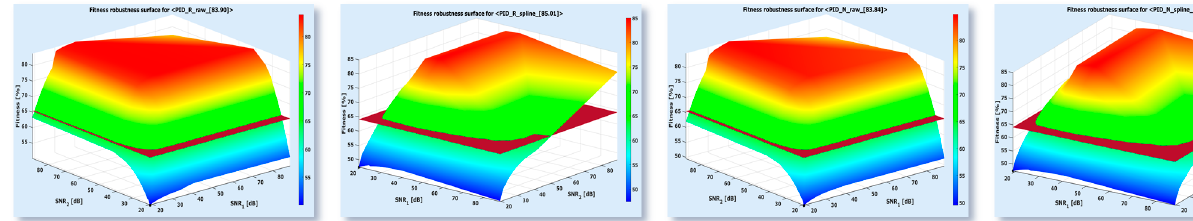
Figure 21. PID-ASTANK2 performance for switched references of the previous figure.